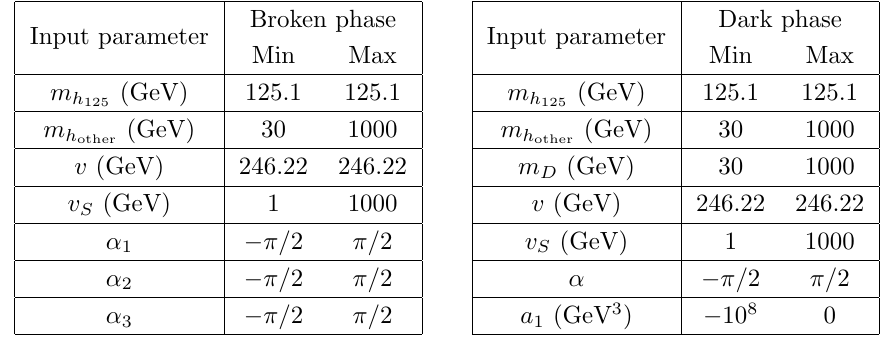
Table 2 . Parameters ranges used for the input parameters for each phase of the CxSM : in both phases, we denote by m h the visible state which is the SM-like Higgs state, and (cid:12)x its mass to 125 the experimental value. In the broken phase (left), m h denotes one of the other visible scalars. other In the dark phase (right), all three masses are input parameters, and m D refers to the dark matter